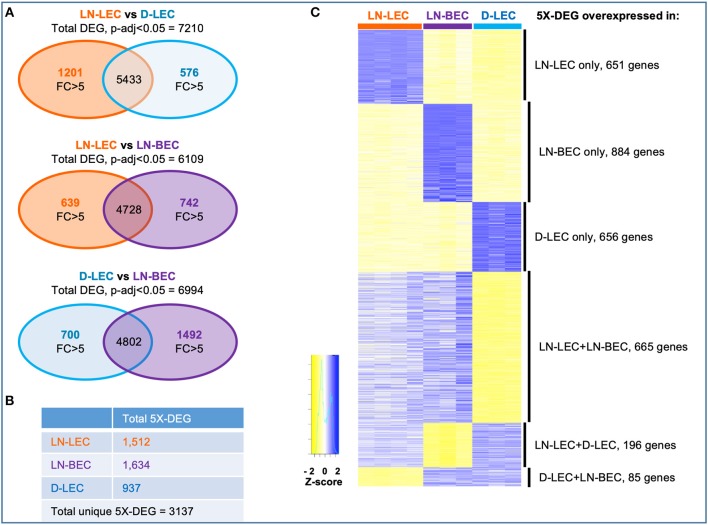
Differential gene analysis and hierarchical clustering of differentially expressed genes in LN-LEC, LN-BEC, and D-LEC revealed distinct and shared subsets by at least two populations. (A) Venn diagrams showing pairwise comparisons of LN-LEC, LN-BEC, and D-LEC. (B) Total number of unique and cell type specific 5X-DEG. (C) Hierarchical clustering of distinct and shared subsets of 5X-DEG. Complete lists of 5X-DEGs in each subset are listed in Table S2.